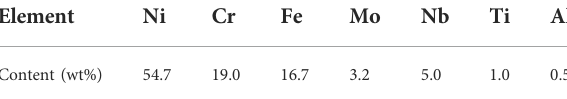
TABLE 2 Parameters in multiphase- fi eld